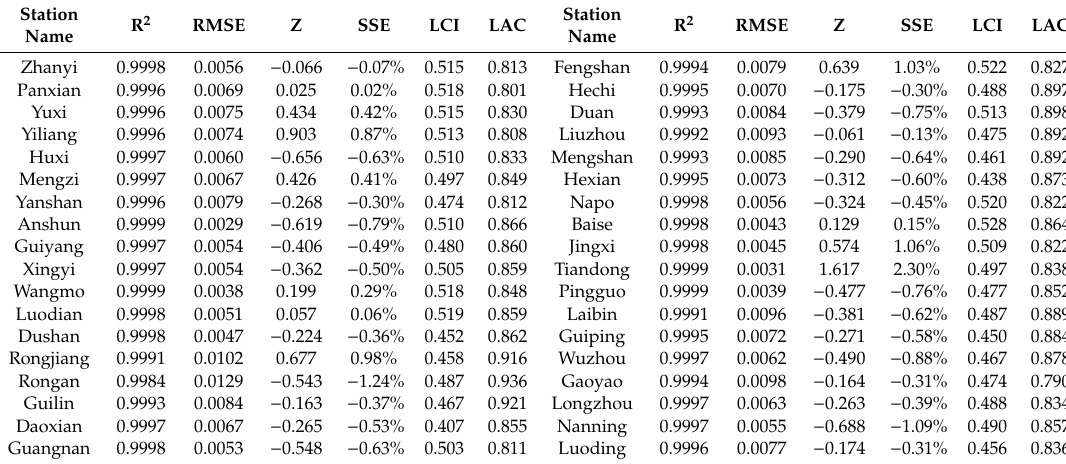
Table 3. Values for coe ffi cient of determination (R 2 ), root-mean-square error (RMSE), Z, Sen’s slope estimator (SSE), LCI and Lorenz asymmetry coe ffi cient (LAC) statistics of monthly precipitation for 36 meteorological stations across Xijiang River basin (1960–2008).